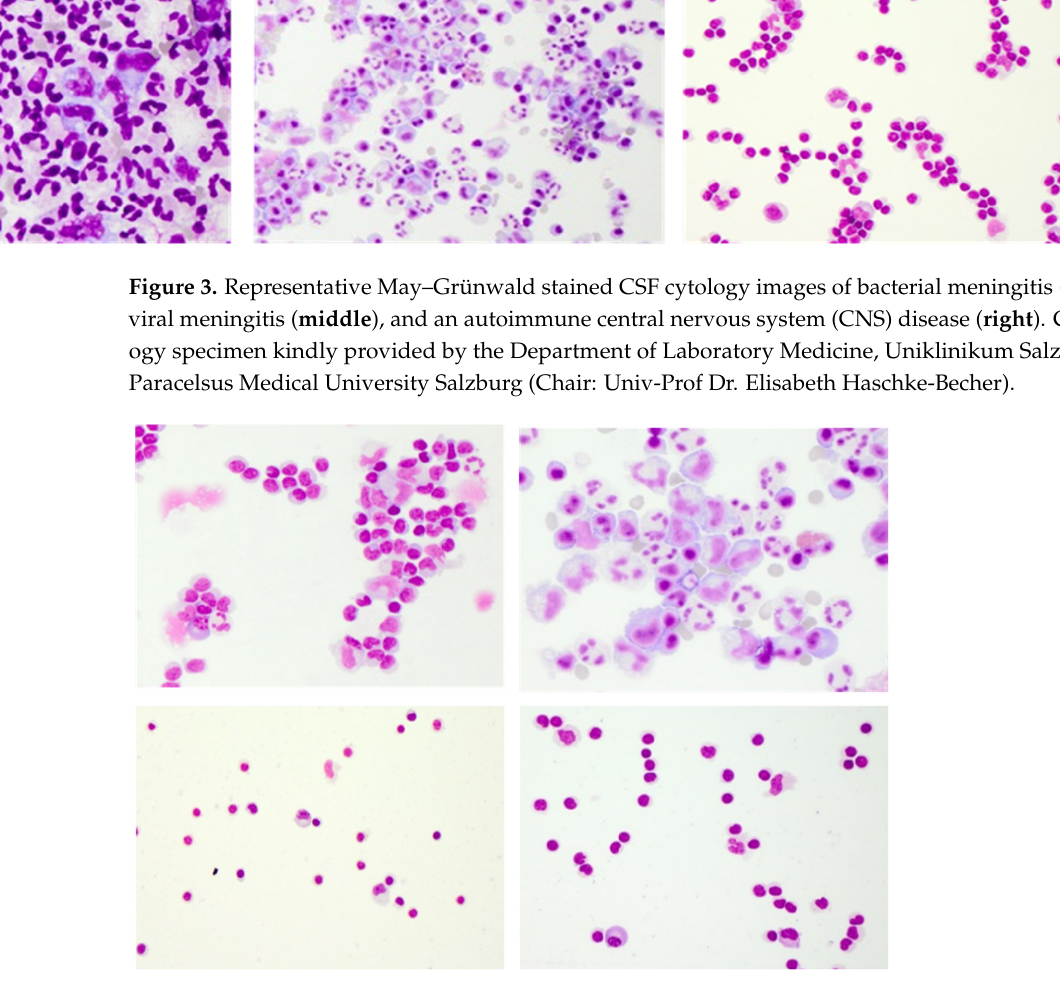
Figure 4. Limitations of conventional CSF cytology. May–Grünwald staining illustrating a case of Lyme neuroborreliosis with antibiotic pre-treatment resembling viral meningitis ( upper left ), an atypical case of Varicella Zoster Virus-meningitis with large hyperreactive cells and plasma cells resembling aseptic bacterial meningitis or Epstein-Barr Virus infection, possibly in malignant trans- formation ( upper right ), and the almost identical cytomorphological findings of the two autoimmune CNS diseases multiple sclerosis ( lower left ) and anti-N-methyl-D-aspartate receptor enceph- alitis ( lower right ). Cytology specimen kindly provided by the Department of Laboratory Medicine,